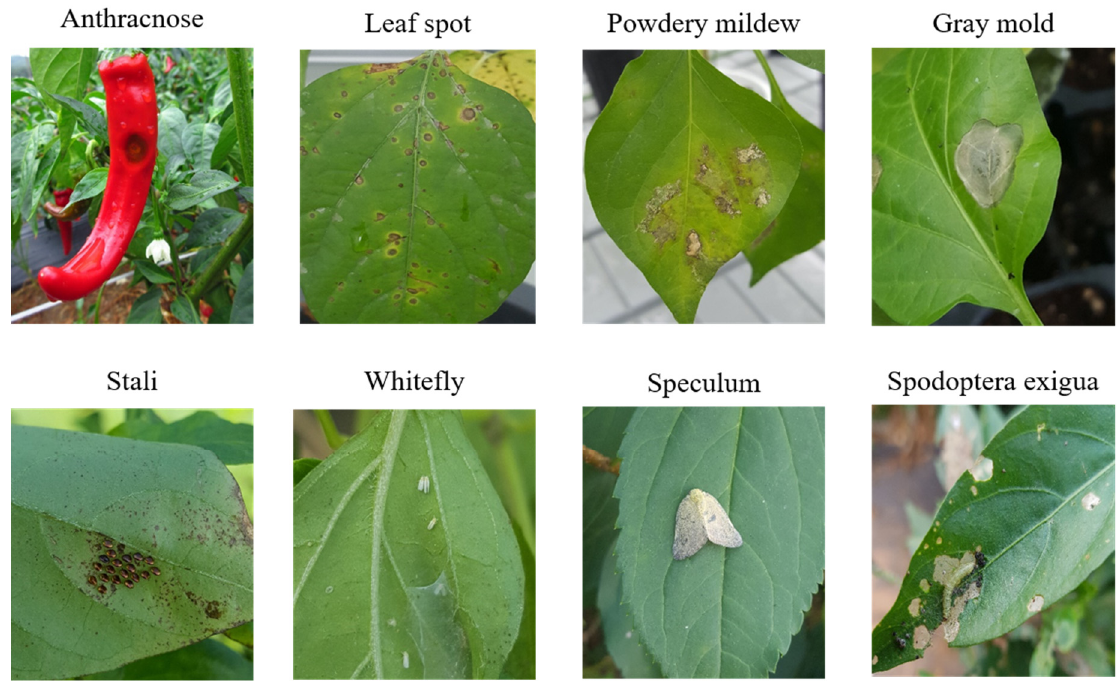
Figure 5. Image dataset of disease and pest.